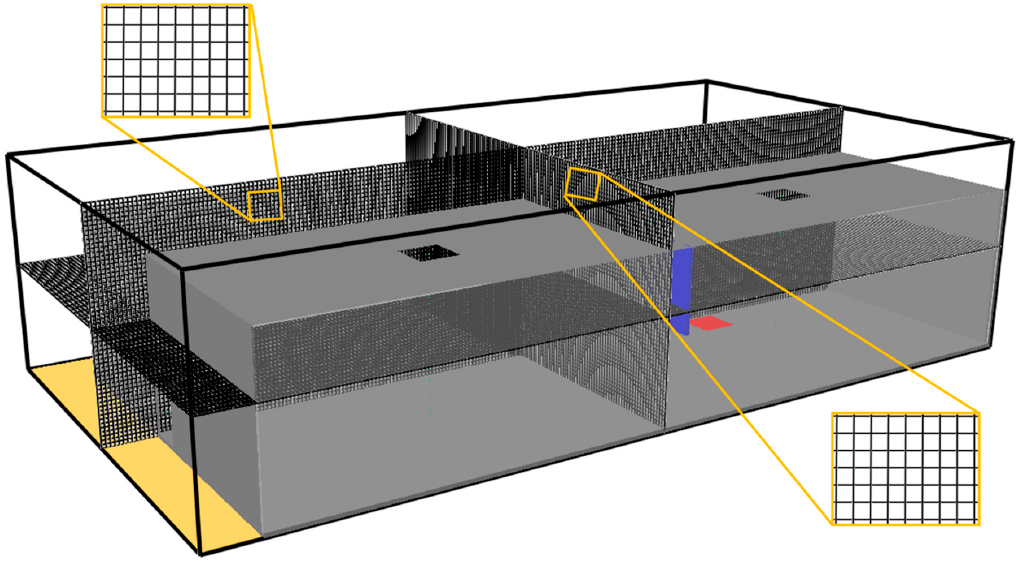
Figure 2. Details of the numerical mesh used in the simulations.